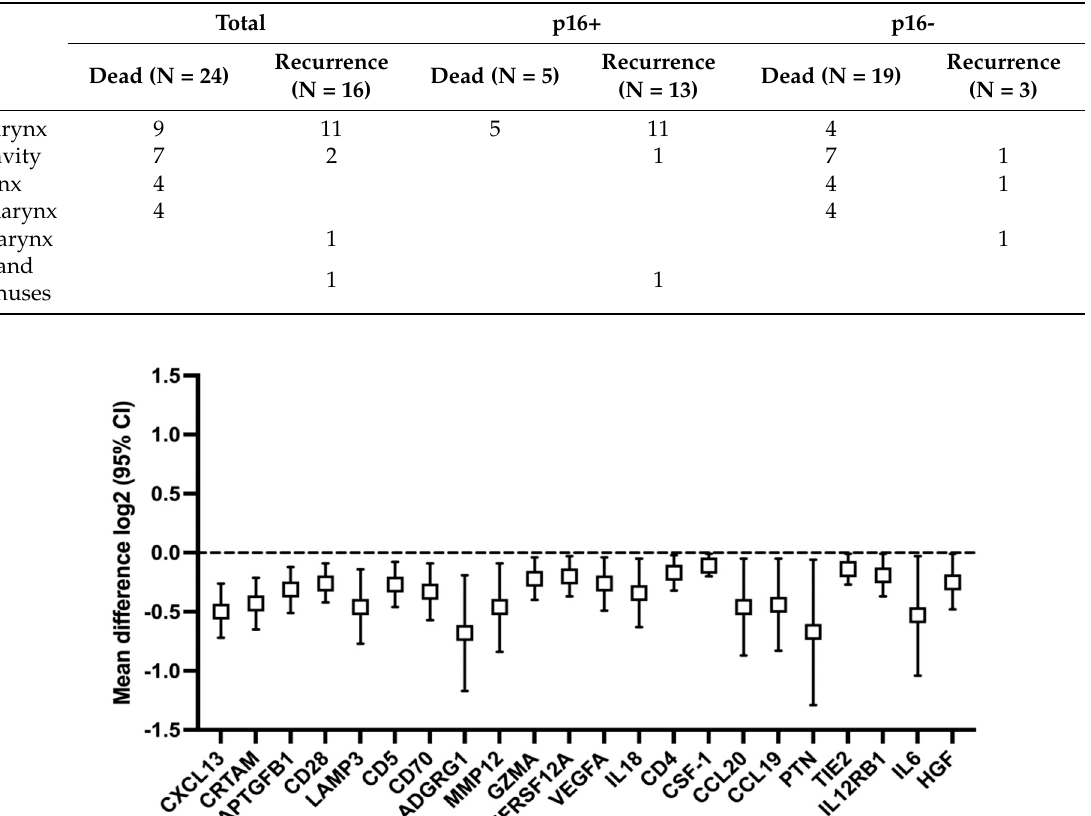
Table 3. p16 status and tumour site for patients with treatment failure (recurrent tumour or death) within two years of the primary therapy.